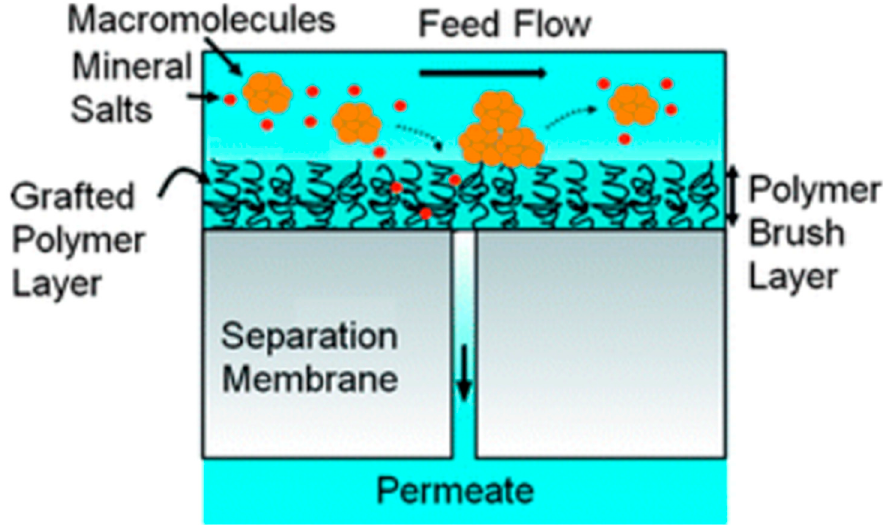
Figure 2. A schematic illustration of the nano-structured RO membrane, showing the antifouling polymeric brush, reproduced with permission from Lin et al. [51], with copyright permission from ©2010 Royal Society of Chemistry.